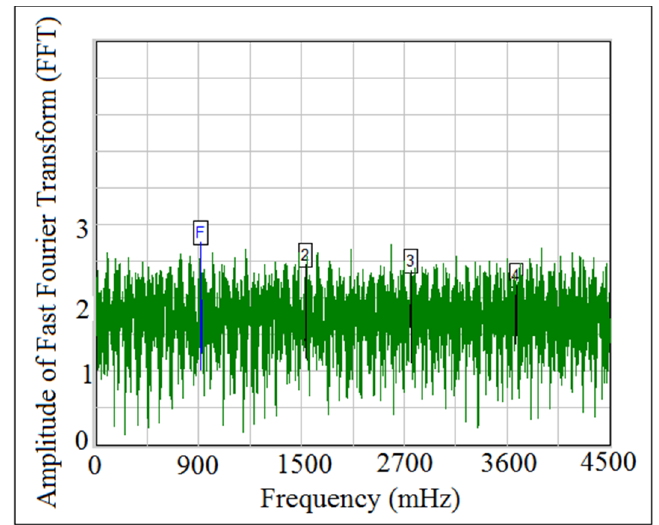
Figure 34. Power density function of the experiment test.